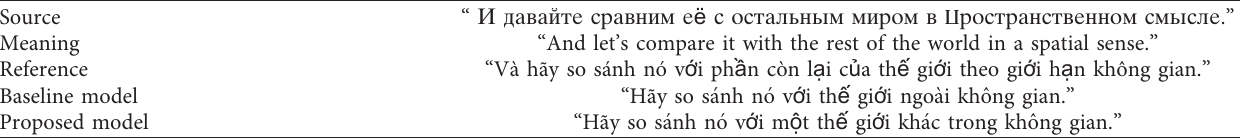
Table 9: Fourth case study with a rare named entity.